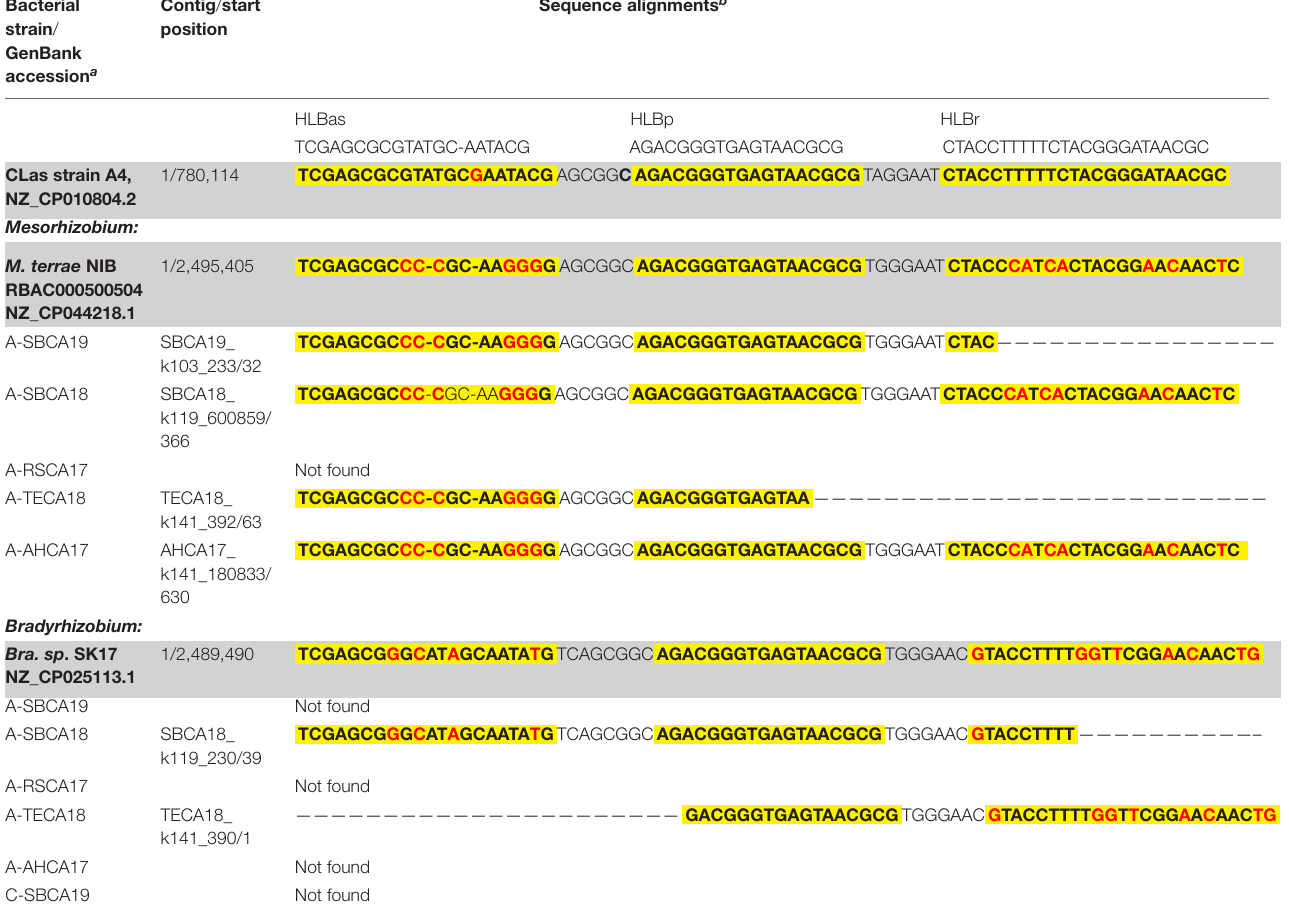
TABLE 4 | Nucleotide sequence comparisons of HLBas/HLBp/HLBr locus among CLas strain A4, Bradyrhizobium and Mesorhizobium strains shown in Figure 2 , and representative strains of Mesorhizobium terrae str. NIBRBAC000500504 and Bradyrhizobium sp. SK17. Bacterial strain